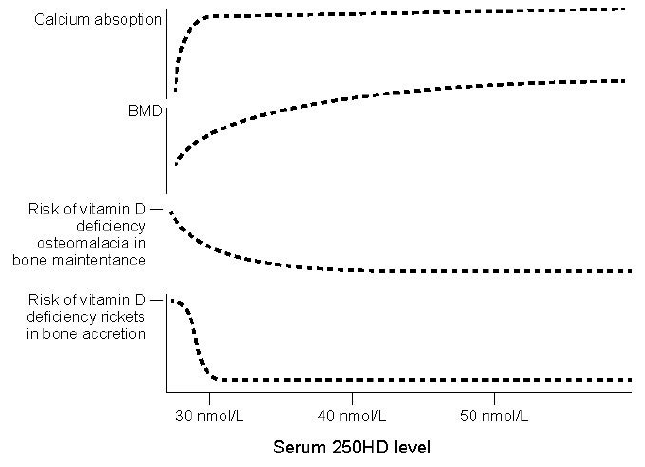
Figure 2. Conceptualization of integrated bone health outcomes and vitamin D exposure (from Institute of Medicine (IOM), 2011 [3], Figure 5-1; reproduced with permission).